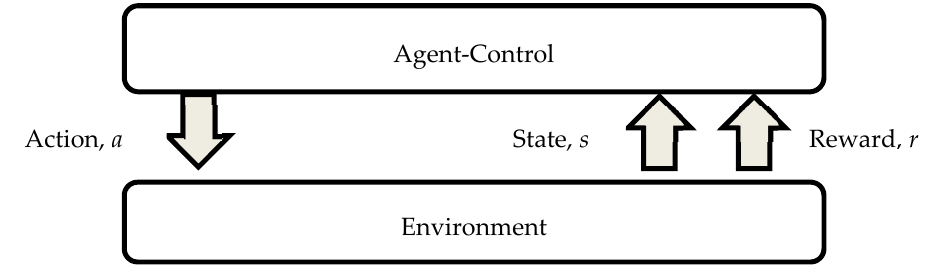
Figure 9. Basic operation of Reinforcement Learning algorithms.